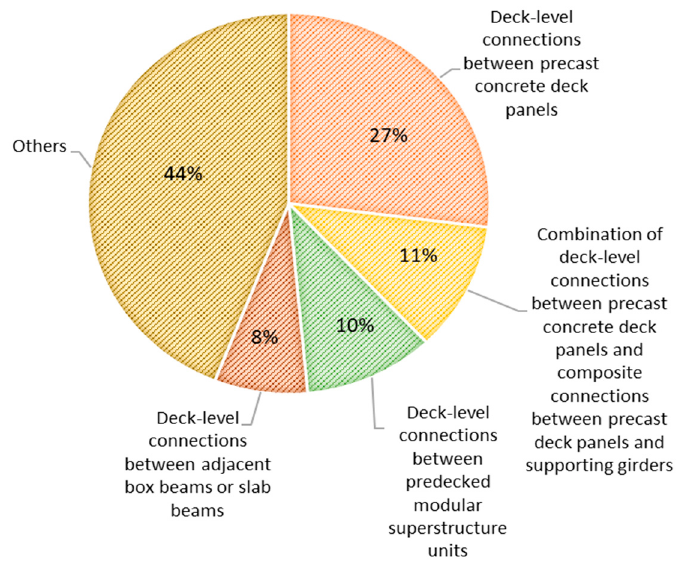
Figure 2. Use of UHPC materials in bridge components in the United States [9].